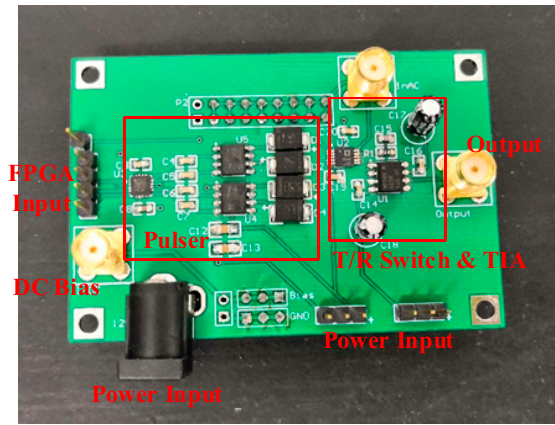
Figure 7. Photograph of the integrated front-end circuit board.